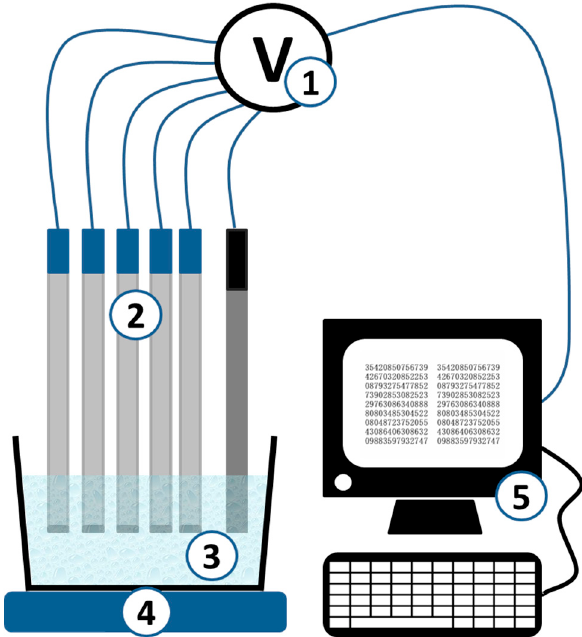
Figure 2. Potentiometric multisensor system. 1—multichannel digital mV-meter, 2—meter, 3—cell with sample, 4—magnet stirrer, 5—personal computer.